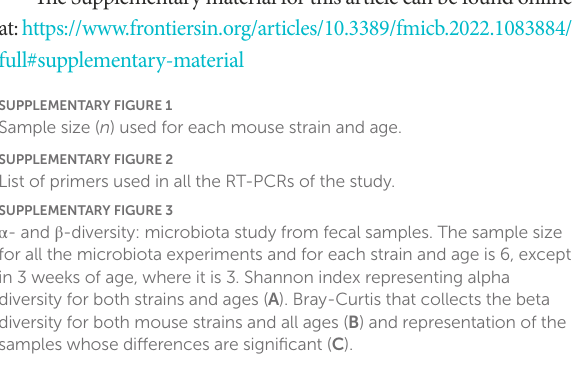
SUPPLEMENTARY FIGURE 1 Sample size ( n ) used for each mouse strain and age. SUPPLEMENTARY FIGURE 2 List of primers used in all the RT-PCRs of the